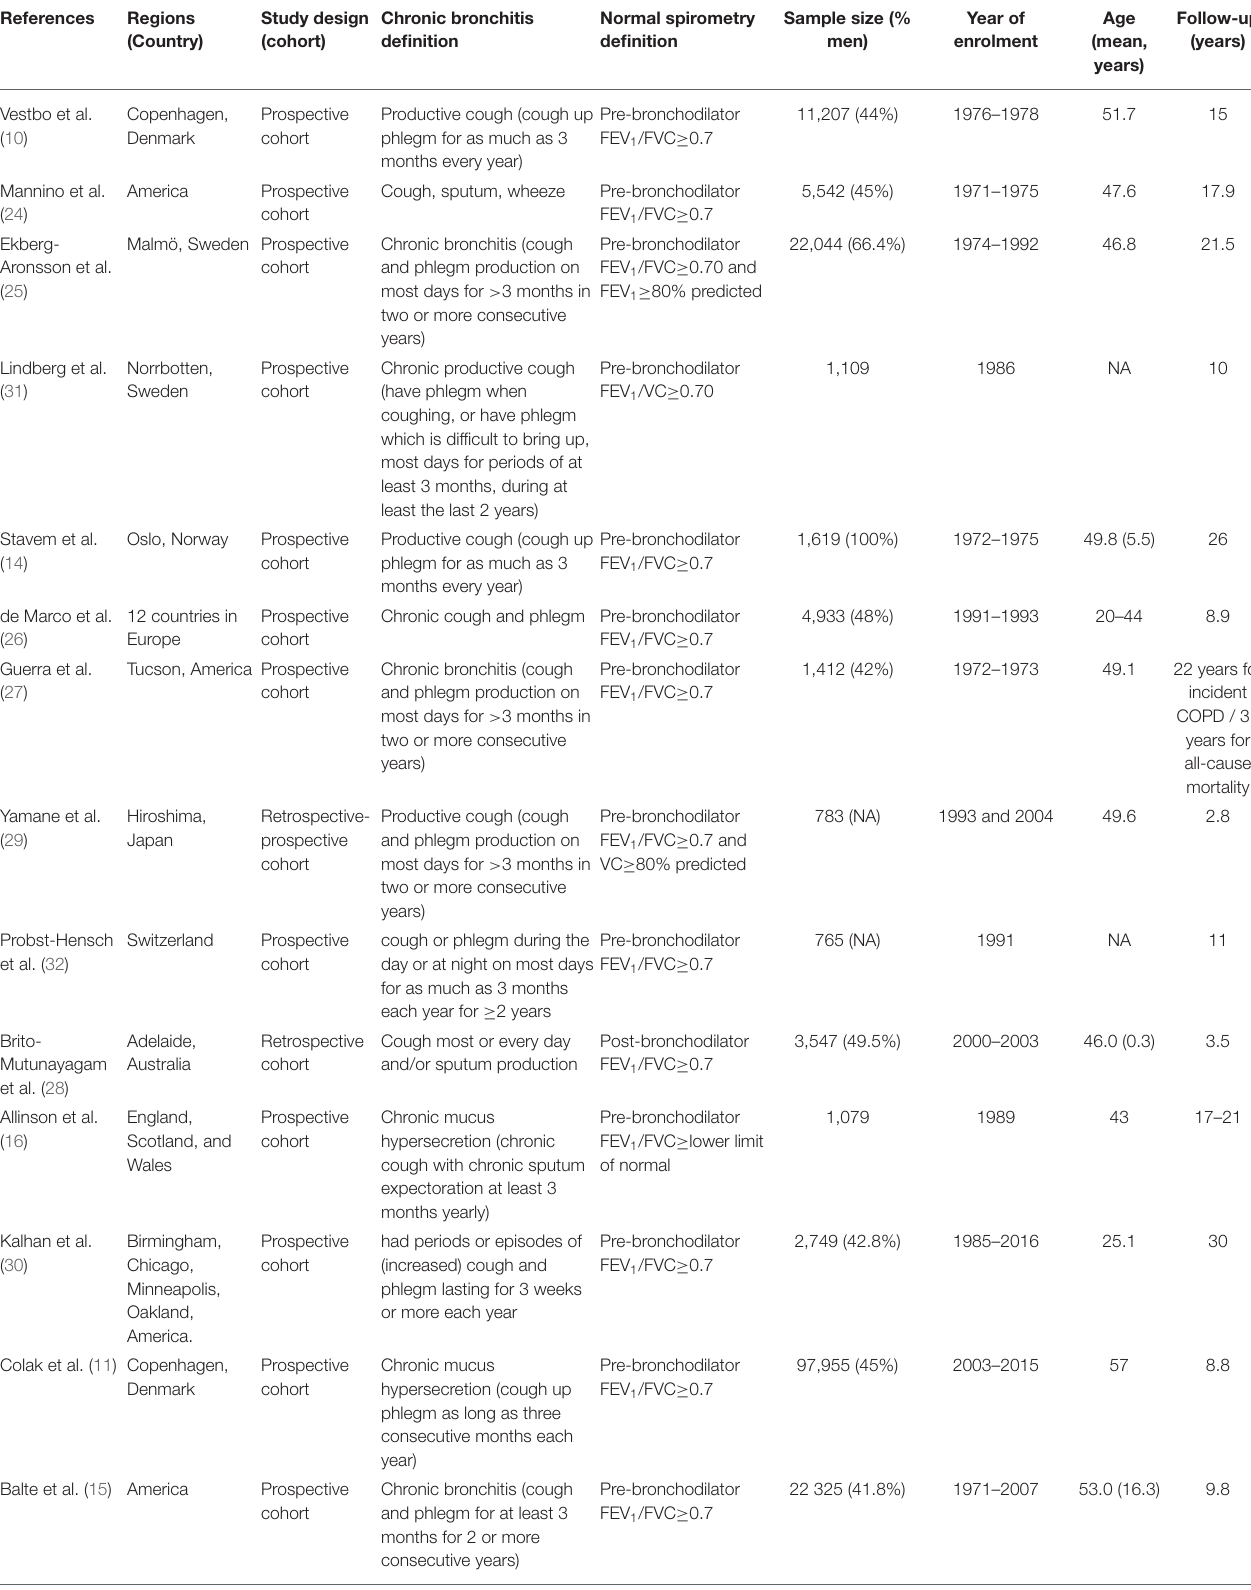
TABLE 1 | Characteristics of all studies included in the